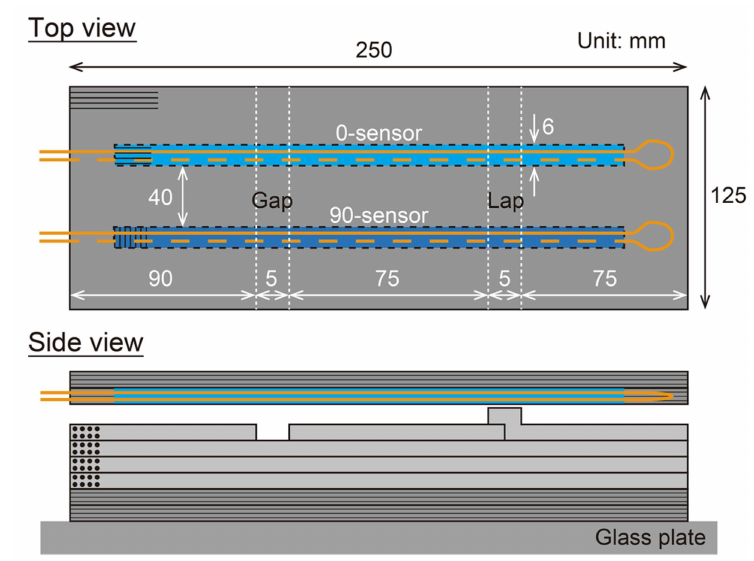
Figure 11. Schematic of specimen for consolidation monitoring.